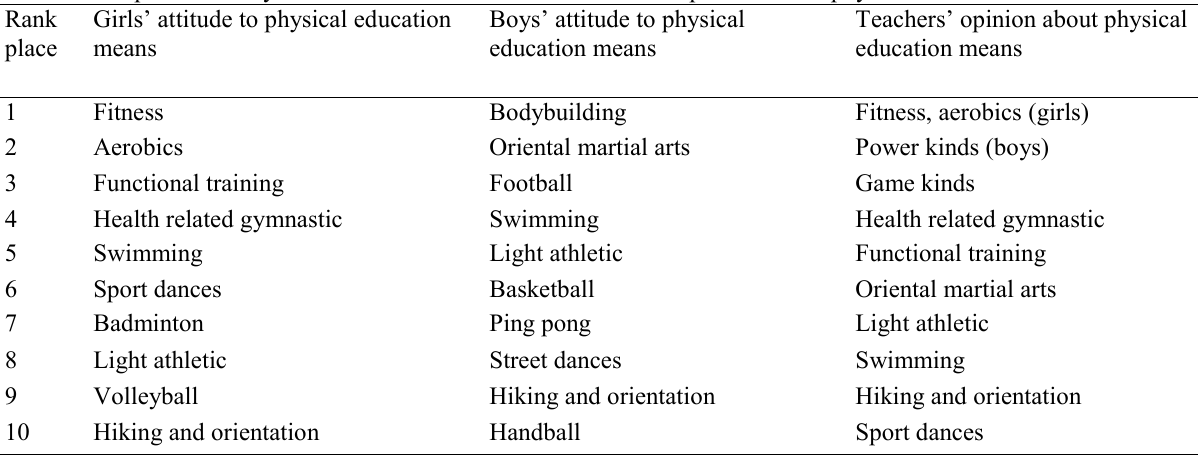
Table 1. Comparative analysis of students’ attitude to and teachers’ opinions about physical education means Rank